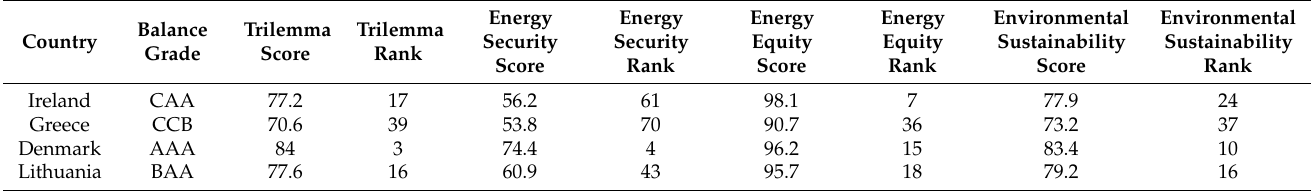
Table 2. Energy Trilemma Index for selected EU countries in 2020 (designed by the authors, based on